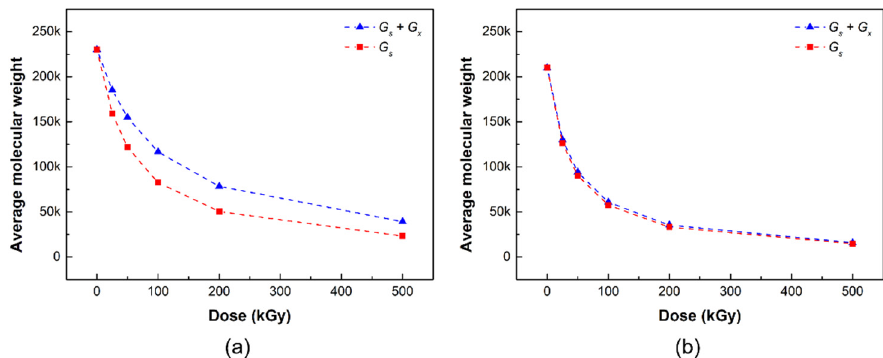
Figure 2. Number average molecular weight of ( a ) PLCL and ( b ) PLDLA radiation damage models depending on the gamma-ray irradiation in simulation (blue triangles: simulation of chain scission and crosslinking; red squares: simulation of chain scission).